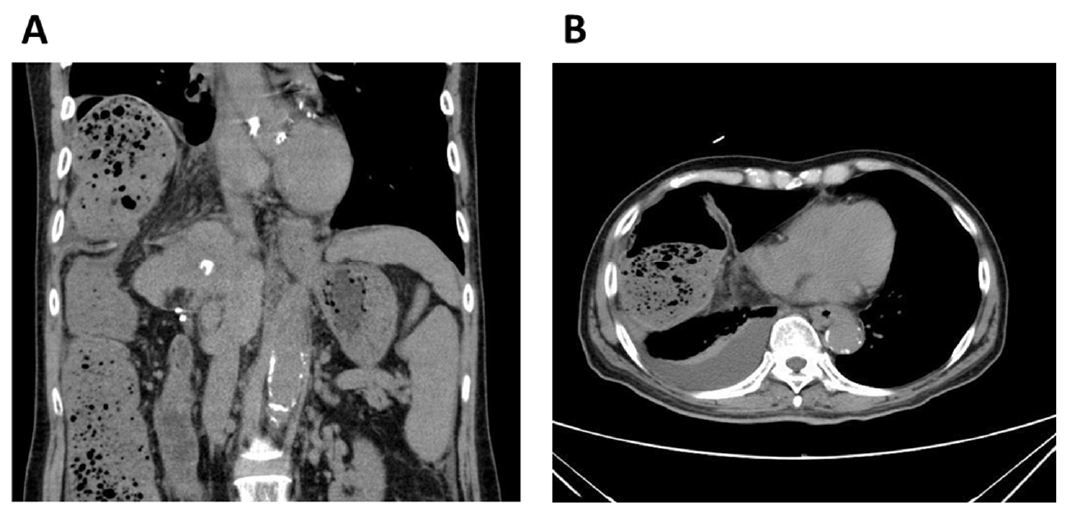
Figure 1. ( A ) Coronal and ( B ) axial views of contrast-enhanced computed tomography reveals a right diaphragmatic hernia of the colon with numerous stools.